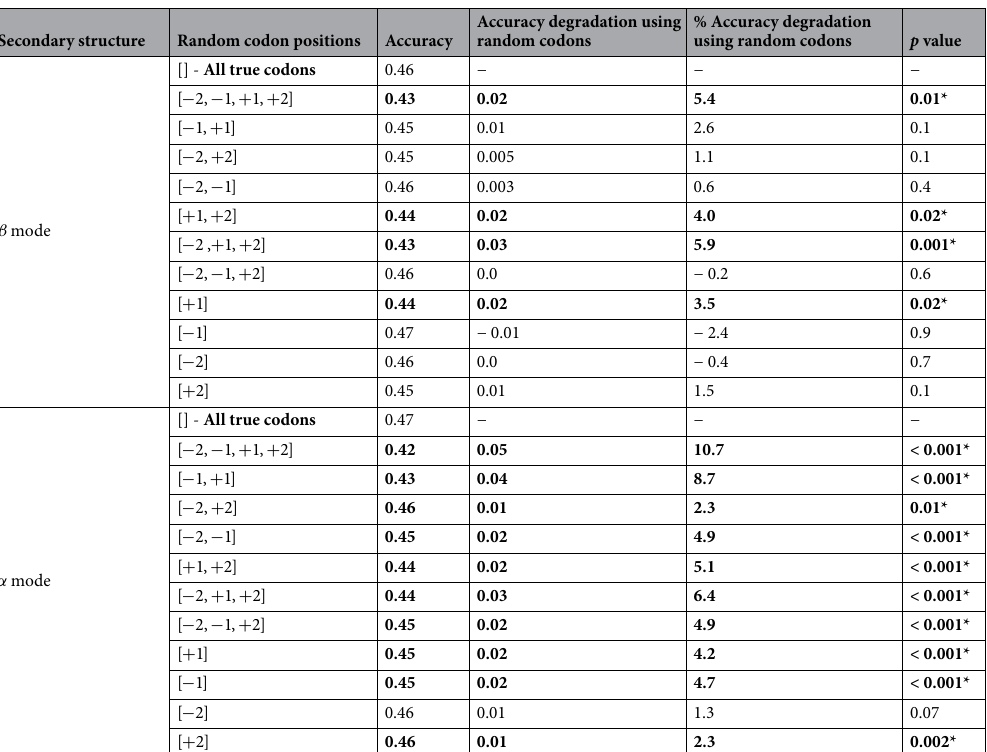
Table 3. Codon context information improves the prediction accuracy of the central codon. The accuracy with which a central codon is predicted was tested when different combinations of context positions were provided with random synonymous codon information. Random codon position indices are arranged according to the central codon which is being predicted. An empty set of random positions corresponds to using true codons in all the positions and this serves as the baseline for calculating accuracy degradation. Significant results ( p value < 0.05 ) are indicated with *. Significant values are in